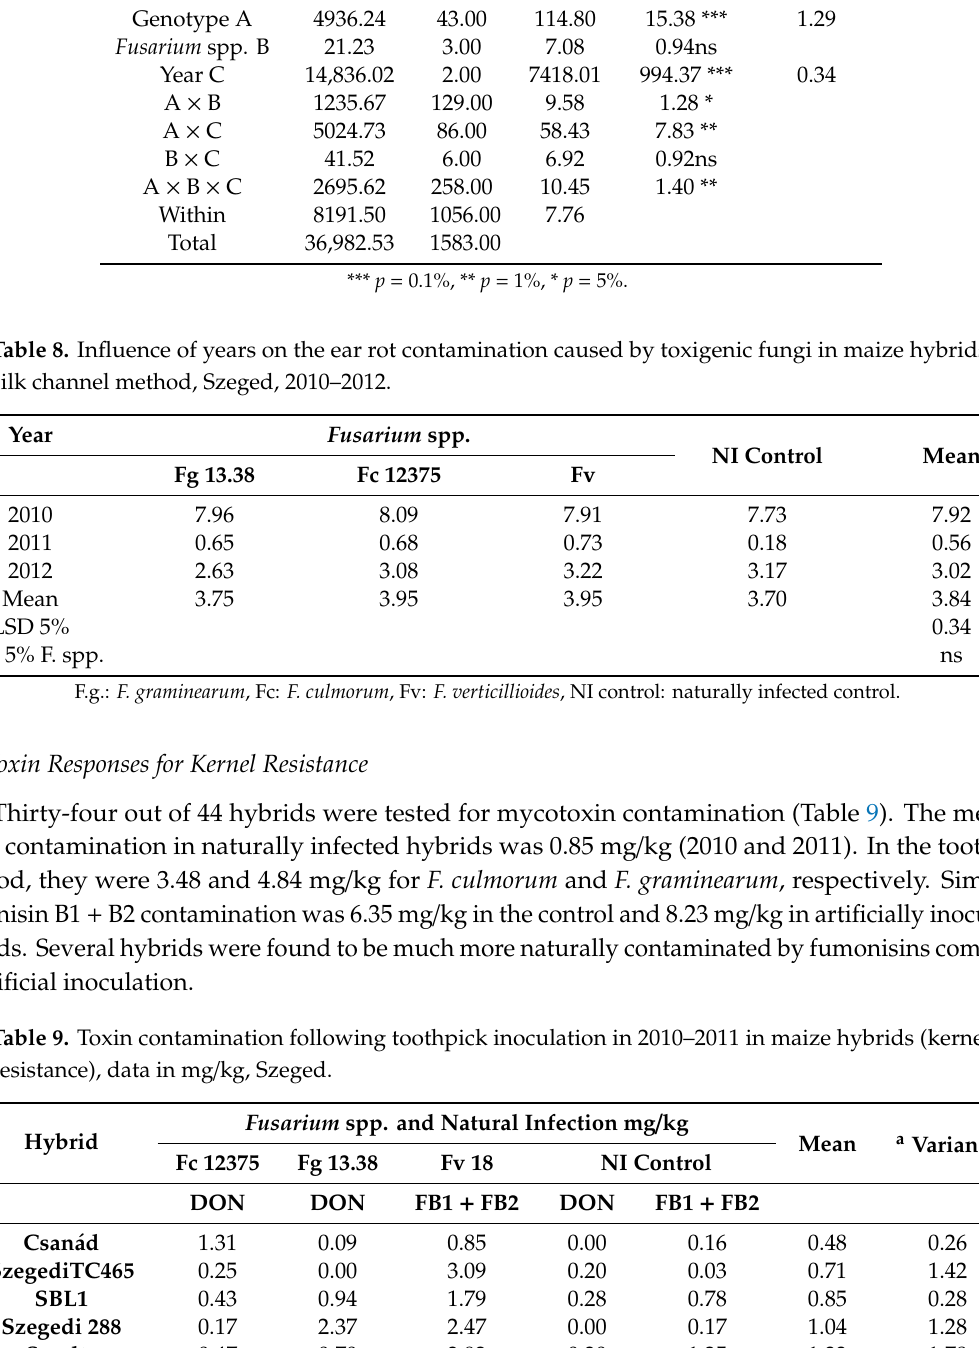
Table 7. Silk channel resistance in maize against Fusarium spp. ANOVA of the data of Table 5. Source of Var.